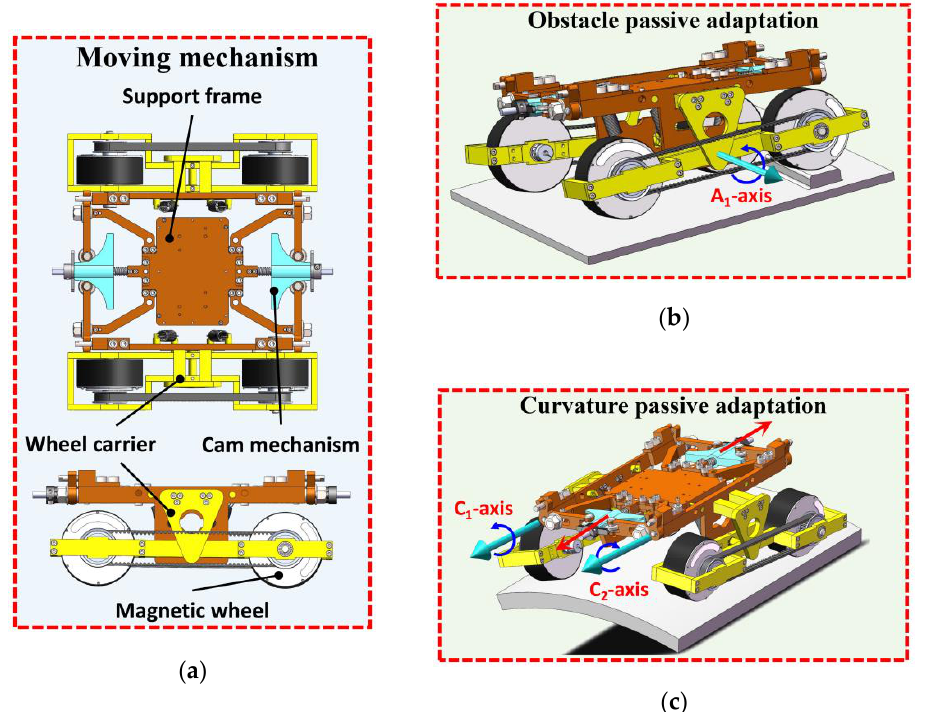
Figure 4. Pseudopodia flexible moving mechanism: ( a ) Moving mechanism structure, ( b ) obstacle crossing process, and ( c ) surface adaptation process.